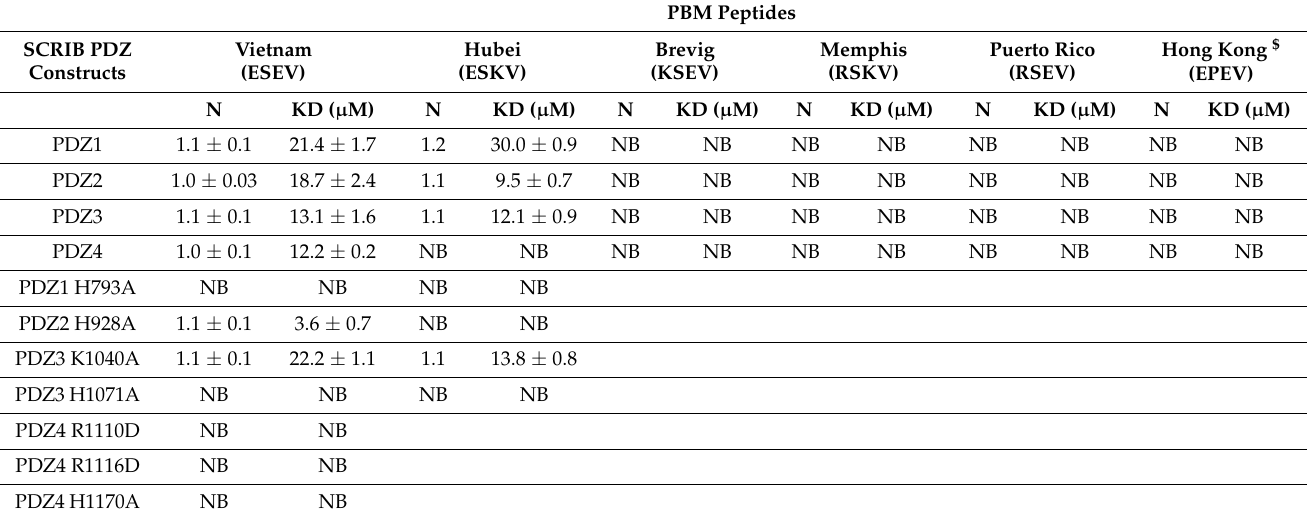
Table 2. Interactions of SCRIB PDZ domains with influenza A virus_NS1 peptides. All affinities were measured using isothermal titration calorimetry, with K D values given in µ M as a mean of three independent experiments with SD. NB stands for ‘no binding’ and N is the average stoichiometry. NB = no binding. $ = negative control. Mutants were not measured for PBM peptides that did not bind to WT SCRIB PDZ